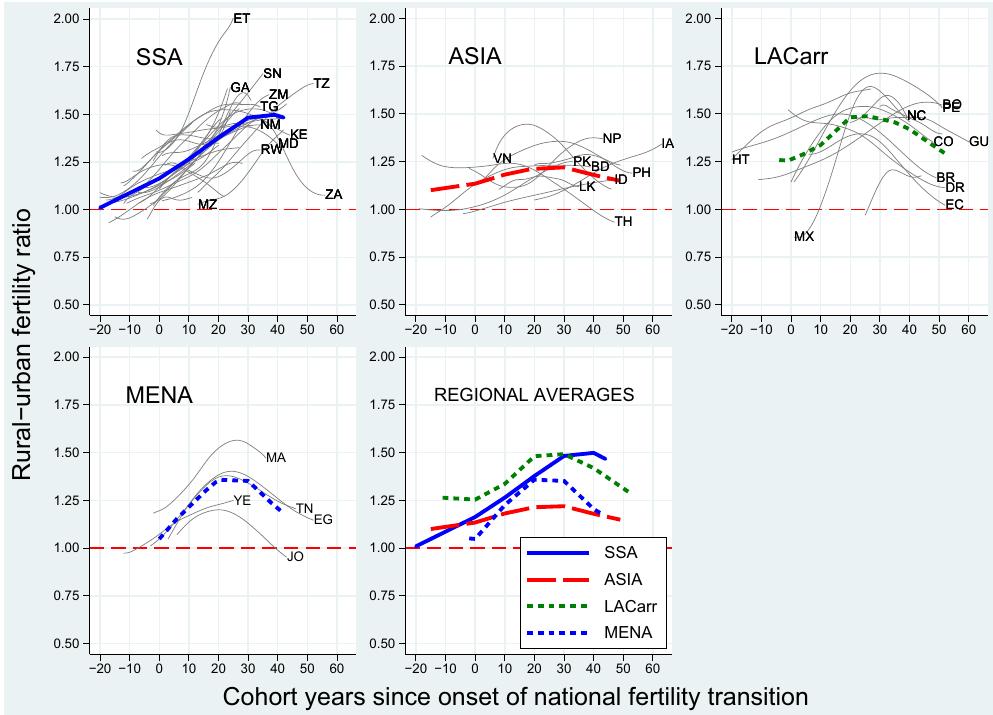
Fig 2. Average and country-specific trends in the rural-urban cohort fertility ratio over the course of the national fertility transitions (onset = year 0), cohorts 1896–1982 in 60 African, Asian and Latin American countries. Source: WFS & DHS, MICS, IPUMS, UN historical and World Population Prospects estimates (2017). Notes: thick lines designate average within-country trends. LACarr = Latin America and the Caribbean, MENA = Middle East and Northern Africa, SSA = sub- Saharan Africa; see Table 1 in S1 File for country acronyms; the onset of the transition corresponds to the calendar year in which the national-level TFR peaked, which was then back-translated by the mean age at birth to get a cohort indicator.